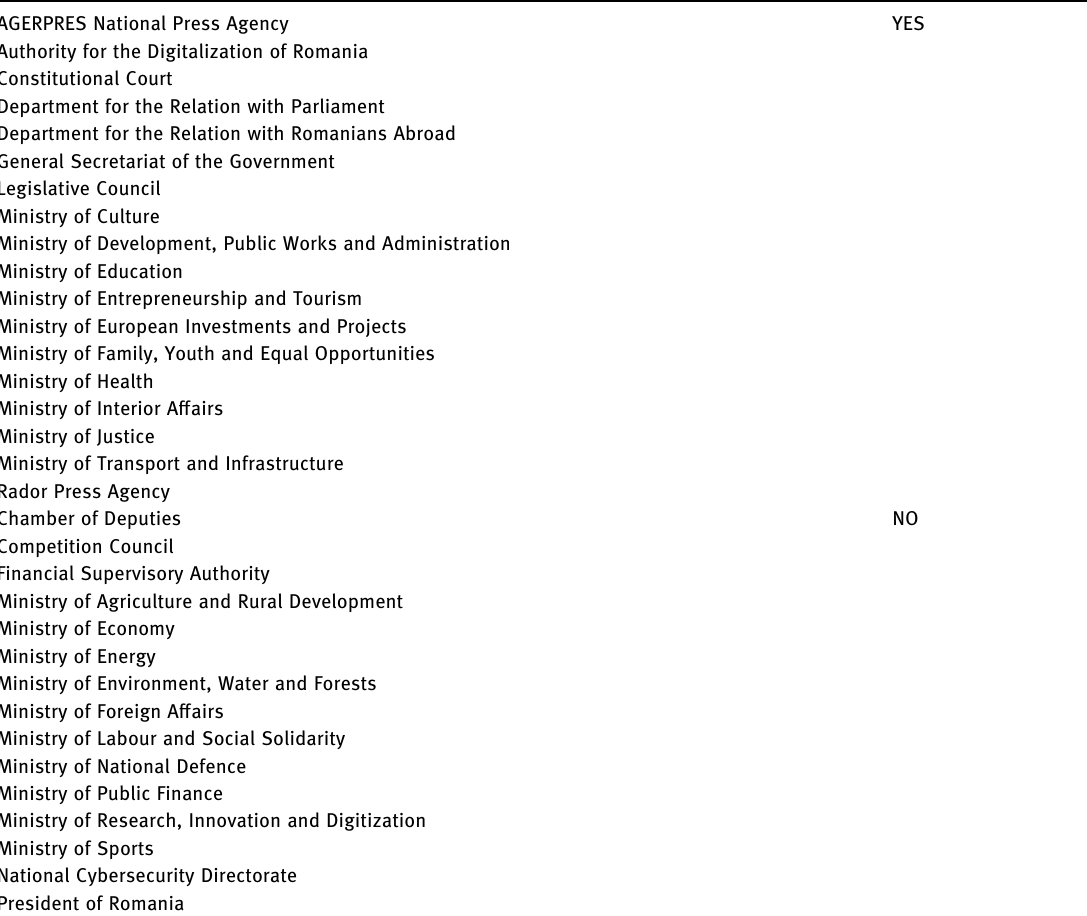
Table 1: Website accessibility of the public institutions on the website of the Government of Romania Public institutions on the website of the Government of Romania Website